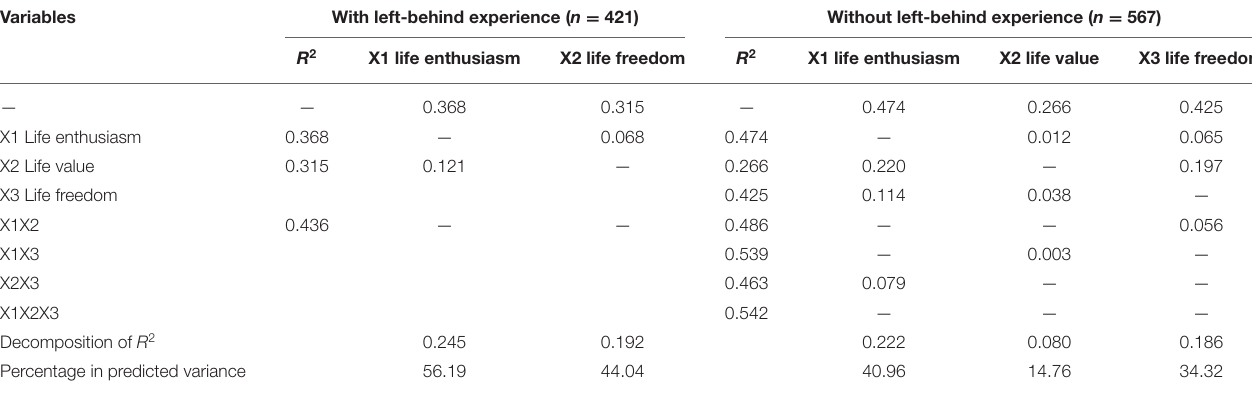
TABLE 6 | Relative importance of each life meaning dimension for social adaptation. Variables With left-behind experience ( n =